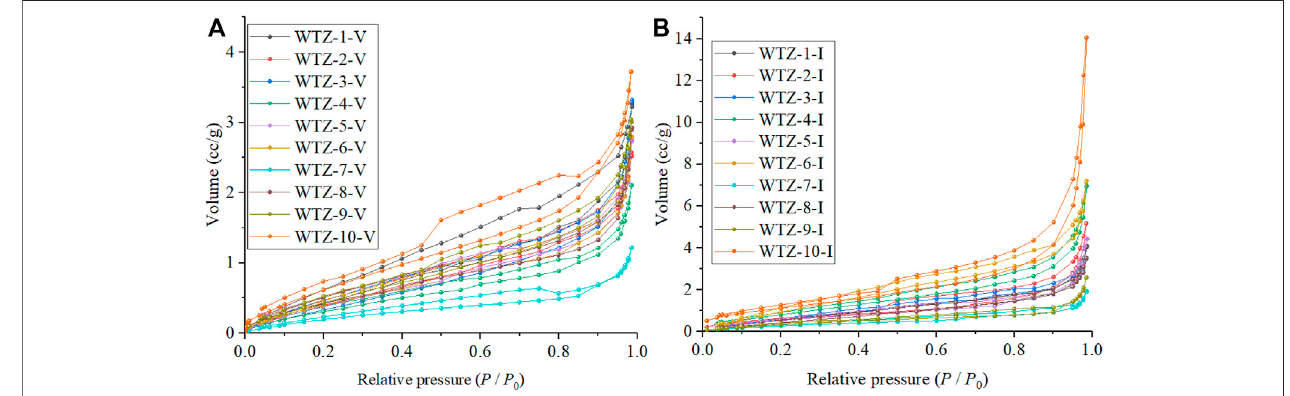
FIGURE 2 | N 2 adsorption/desorption curves of vitrinite (A) and inertinite (B) .